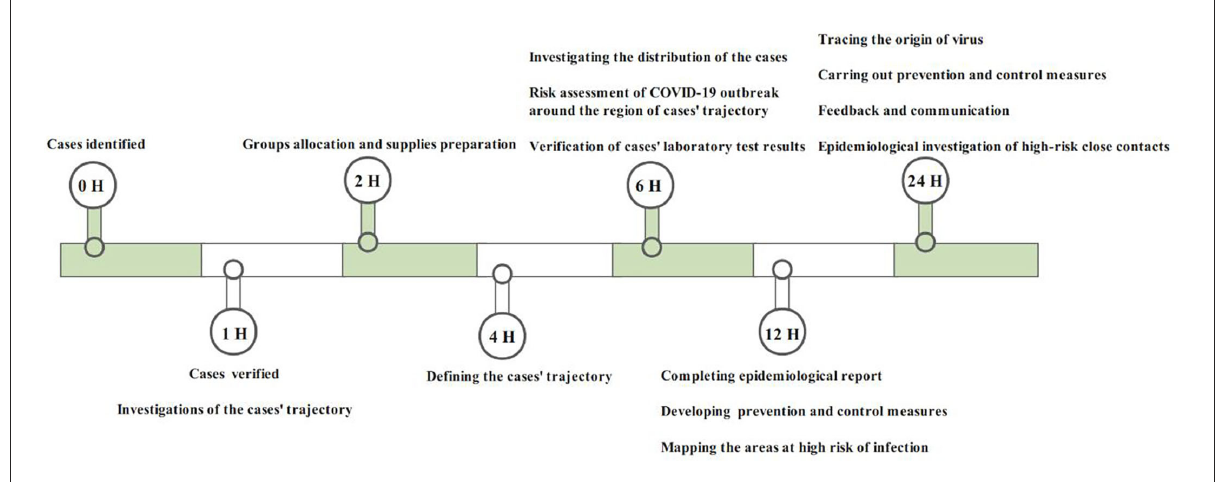
FIGURE1 “24-h” epidemiological survey